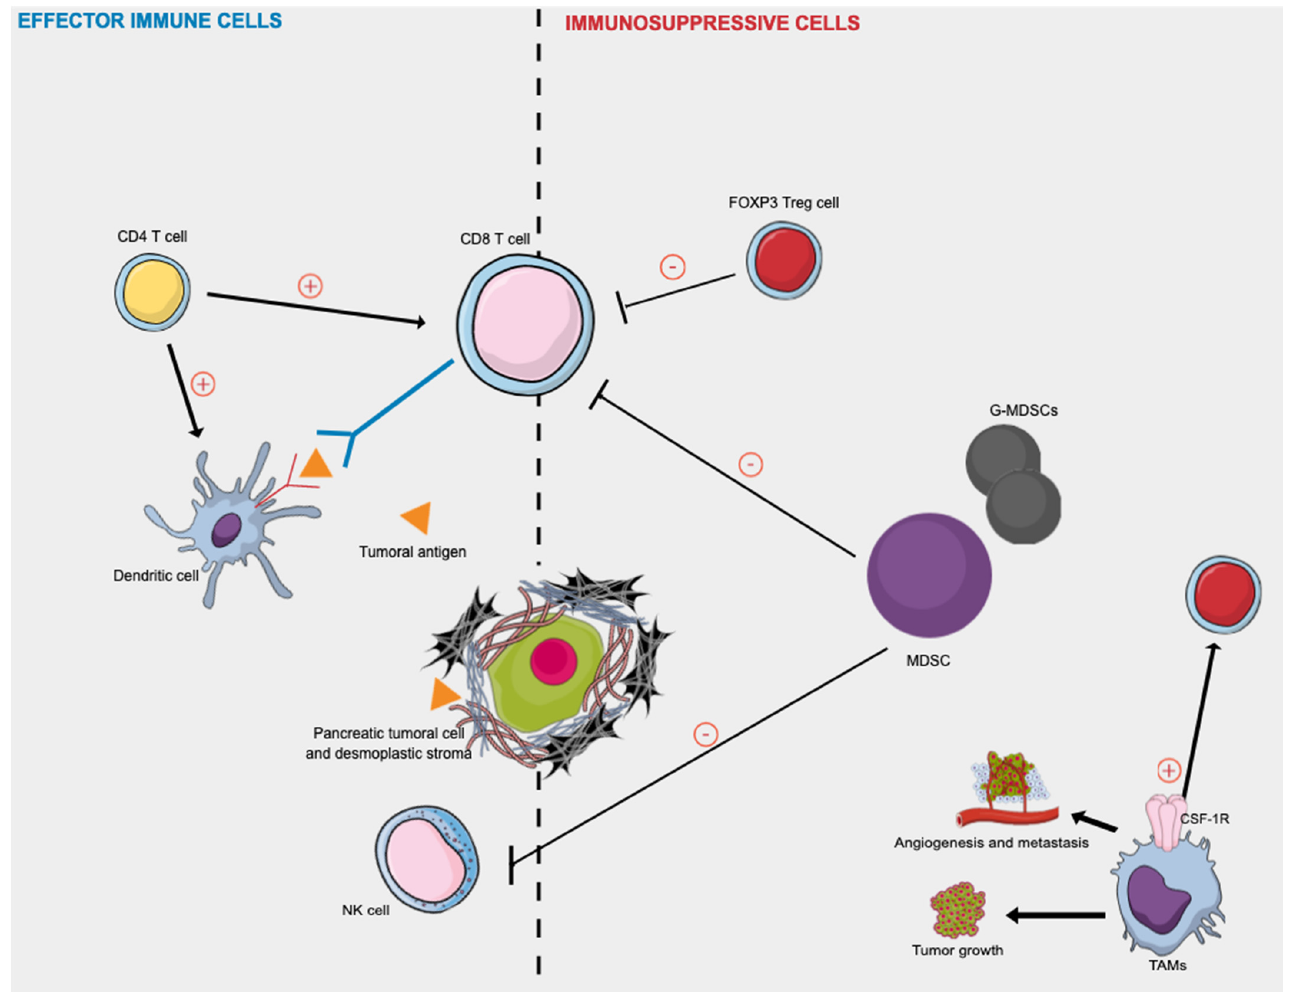
Figure 2. Effector immune cells and immunosuppressive cells in human pancreatic cancer. Activated CD8 + T cells attack tumor cells presenting tumor-associated antigens peptides on their surface, as dendritic cells. CD4 + T cells target tumor cells either directly by eliminating tumor cells through cytolytic mechanisms or indirectly by modulating the TME. Tregs and MDSCs cells play immuno- suppressive roles in inhibiting the immune response against PDAC cells by directly inhibiting the anti-tumor functions of T and NK cells. The TAM phenotype is a consequence of the continuous presence of growth factors such as colony-stimulating factor-1 (CSF1) and its receptor (CSF-1R). TAMs release various growth factors and cytokines and promote tumor cell invasion, induce angi- ogenesis, suppress antitumor immunity, and facilitate tumor cell metastasis. CSF-1R: colony-stimu- lating factor-1 receptor; MDSC: myeloid-derived suppressor cells; NK: natural killer; TAMs = tu- mor-associated macrophages; Treg = regulatory T cell.